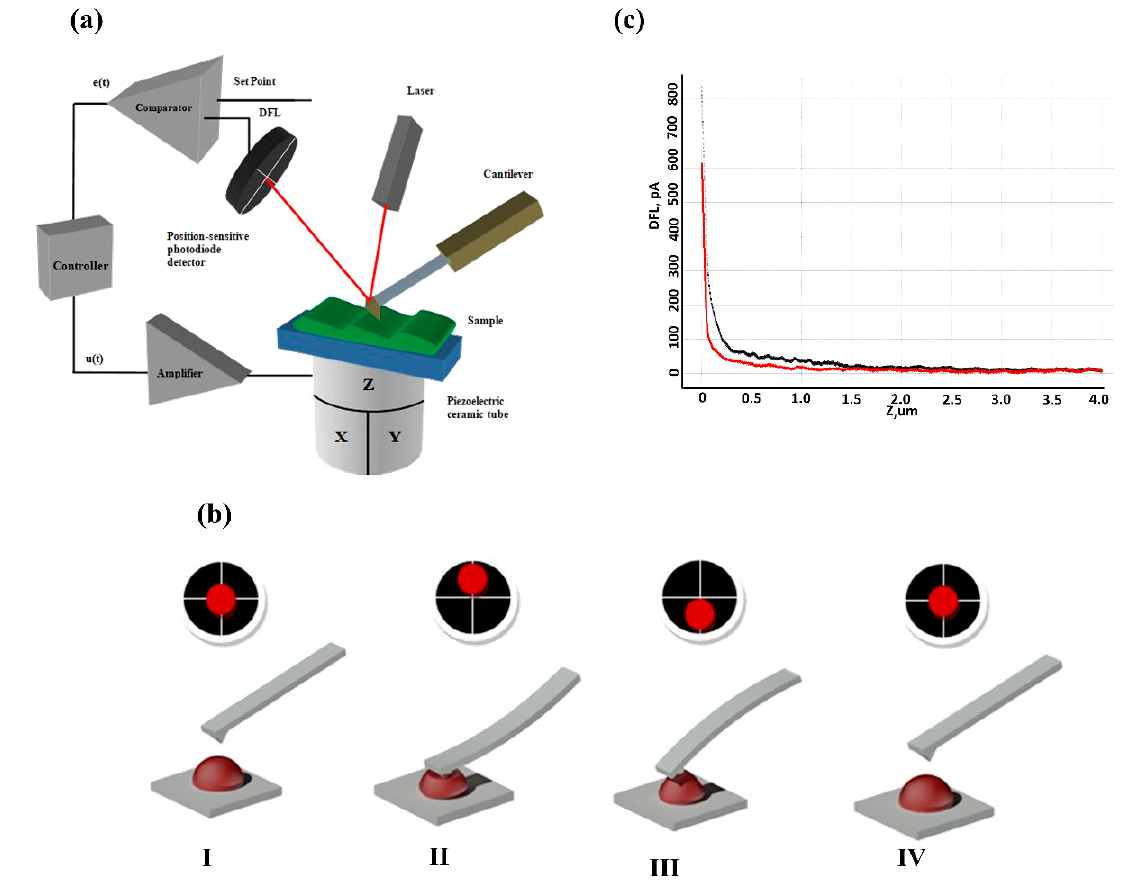
Figure 1. The principles of the atomic force microscopy operation. ( a ) Block diagram of AFM; ( b ) Measurement of blood cell membrane stiffness by AFM. I: the scanner is brought to the cell membrane; the laser spot is located in the center of the photodiode. II: the probe indents the cell membrane; the laser spot moves up relative to the center (located in the upper sections). III: the probe is detached from the cell membrane; the laser spot moves down relative to the center (located in lower sections). IV: the piezo scanner is taken away from the cell; the laser spot is located in the center of the photodiode. ( c ) Empirical force curve. The forward motion is black, the reverse motion is red.